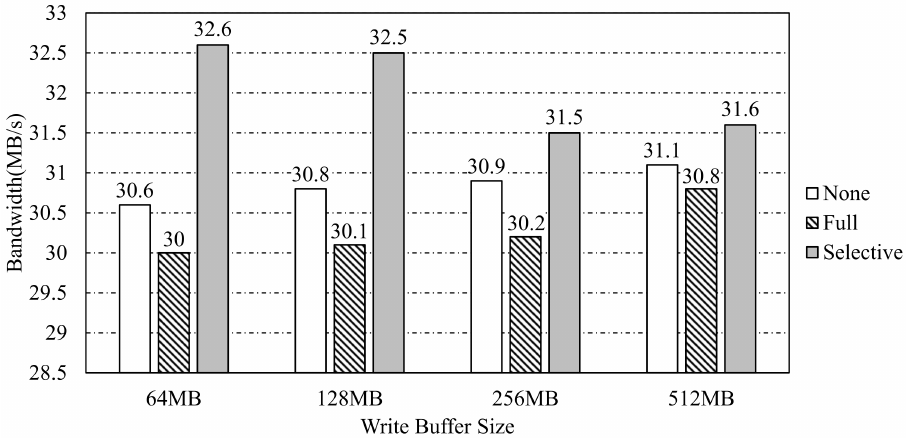
Figure 11. Performance evaluation results of overwrite workload with varying buffer